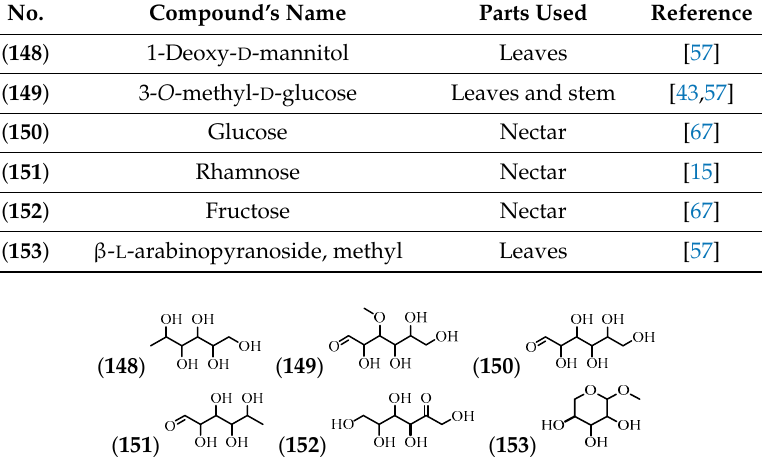
Table 9. The carbohydrates from A. cathartica .